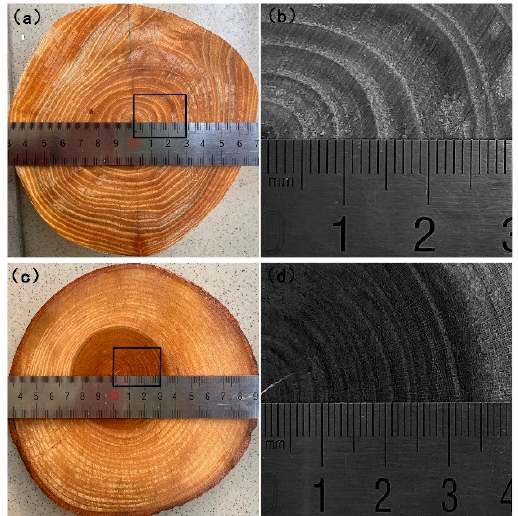
Figure 11. Sample images of broad-leaved tree species. ( a ) Digital image of Ulmus pumila L. analytic wood disk; ( b ) the enlarged picture in the system of the box in the Figure 11a; ( c ) digital image of Zelkova serrata (Thunb.) Makino analytic wood disk; ( d ) the enlarged picture in the system of the box in the Figure 11c.